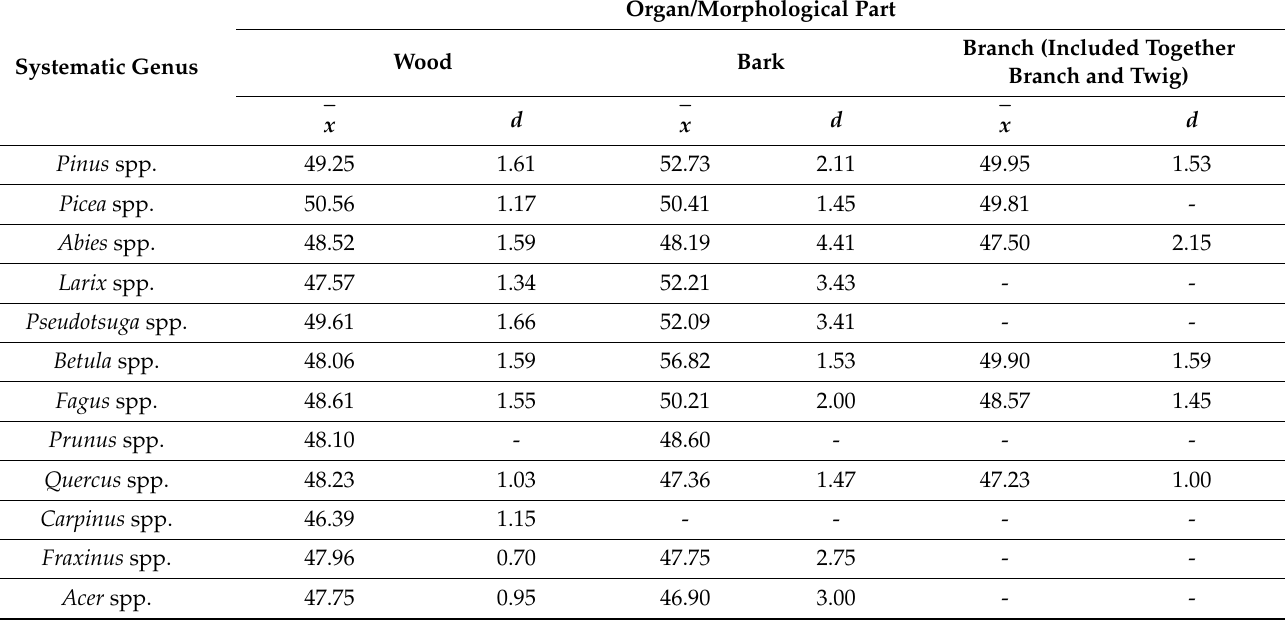
Table A16. Average value and average deviation of the carbon content (% d.m.) in various organs of particular systematic genera